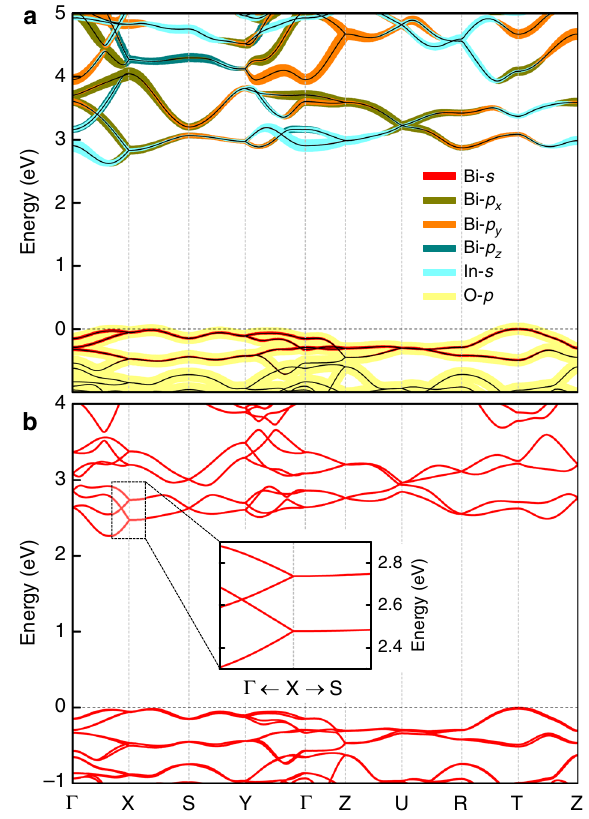
Fig. 3 Crystal structure of bulk BiInO 3 . a 3D view of the unit cell structure. Fig. 4 Band structure of bulk BiInO 3 . a, b Band structure along the high symmetry lines in the Brillouin zone without SOC ( a ) and with SOC ( b ). b , c View of the crystal structure in the (100) plane ( b ) and the (001) plane ( c ). The twofold screw rotation axis ( (cid:1) C Orbital-contributions in panel a are shown by color lines with thickness ) and the glide re fl ection 2 z proportional to the orbital weight. Inset in panel b shows the band structure planes ( (cid:1) M x and (cid:1) M y ) are indicated by the dashed lines. The dotted line zoomed in around the X indicates a Pnma symmetry mirror plane